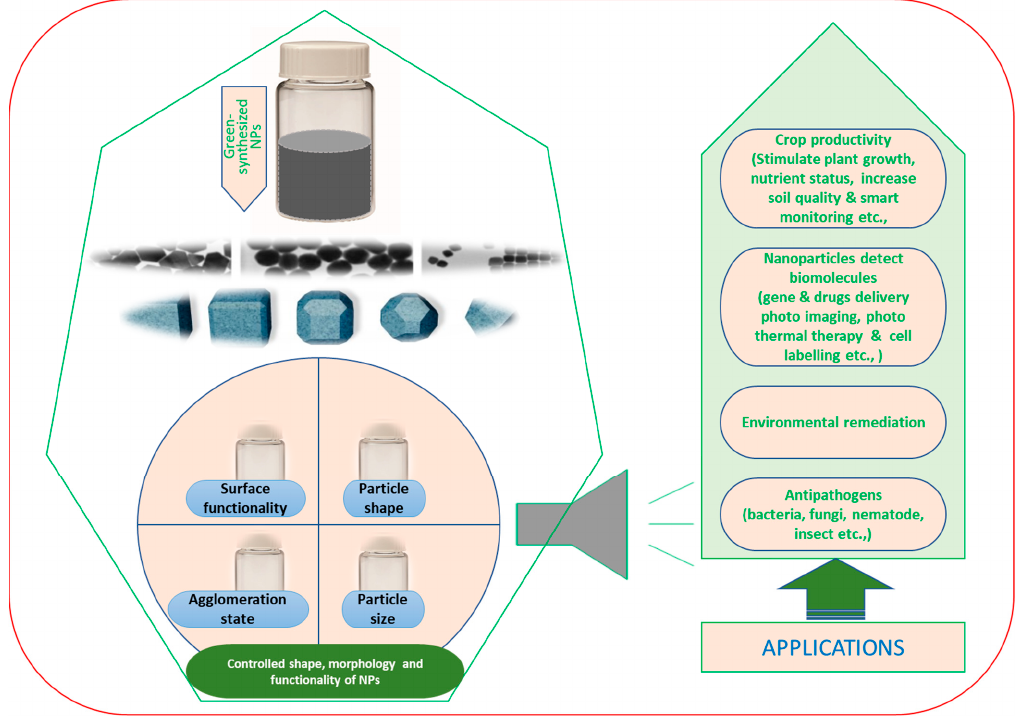
Figure 6. An overview diagram shows synthesized nanoparticles (NPs) produced via the green route for various biological applications. The different sizes, shapes and surface bio ‐ functionalized NPs are developed in a controlled way for the target application.